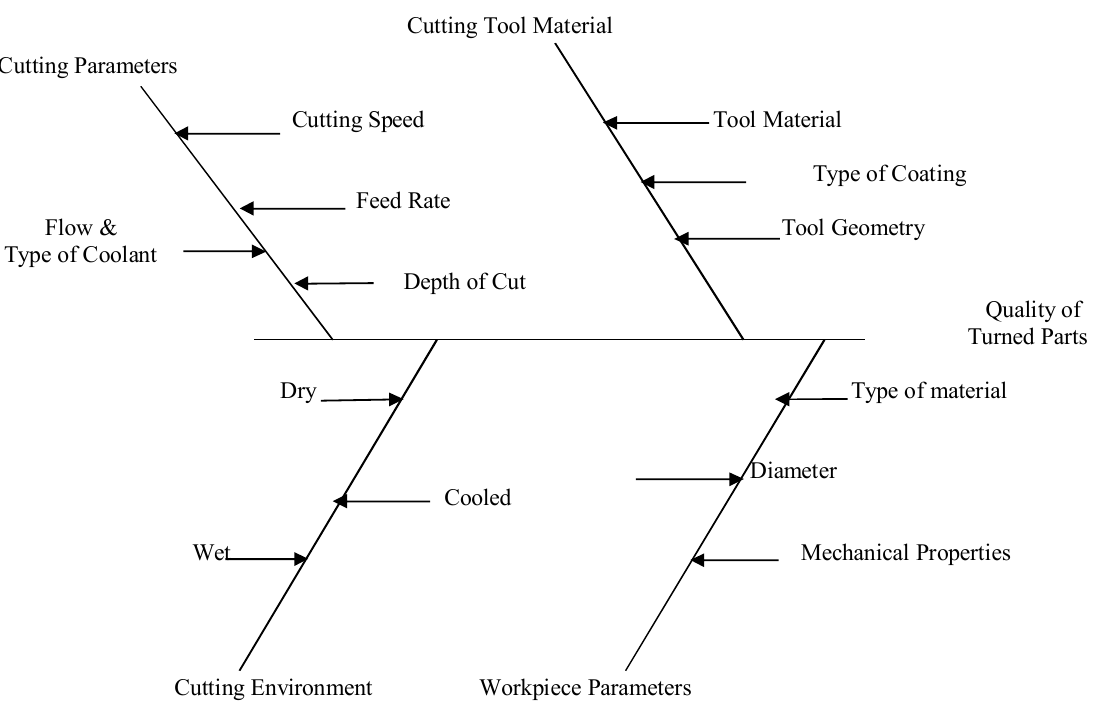
Fig. 1. Ishikawa Cause-Effect Diagram of a Turning